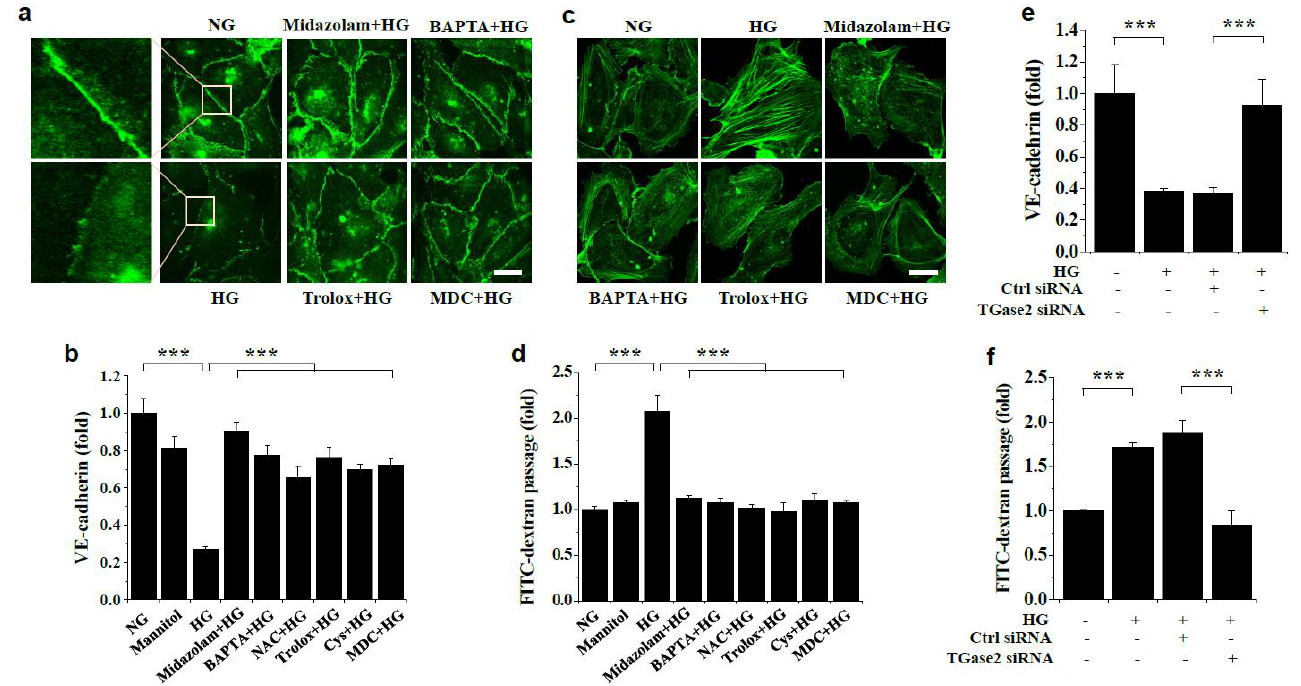
Figure 5. Effects of midazolam and inhibitors on high glucose-induced VE-cadherin disruption, stress fiber formation, and endothelial cell monolayer permeability in HGECs. HGECs were treated for 3 days with normal glucose (NG) or high glucose (HG) in the presence of 20 μ mol/L midazolam, 5 μ mol/L BAPTA-AM, 1 mmol/L NAC, 0.5 μ mol/L Trolox, 50 μ mol/L cystamine, or 20 μ mol/L MDC.